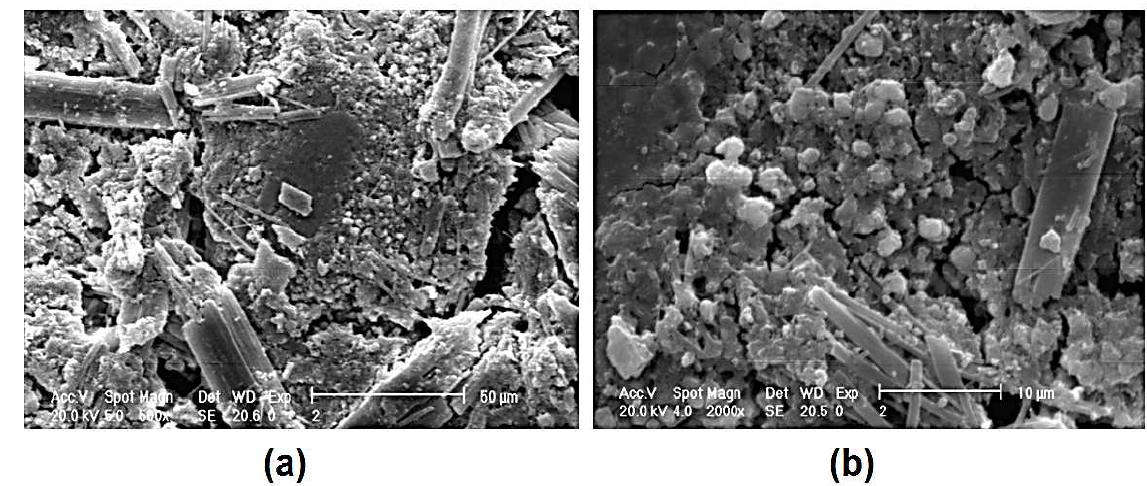
Figure 2. Scanning electron microscope (SEM) images of